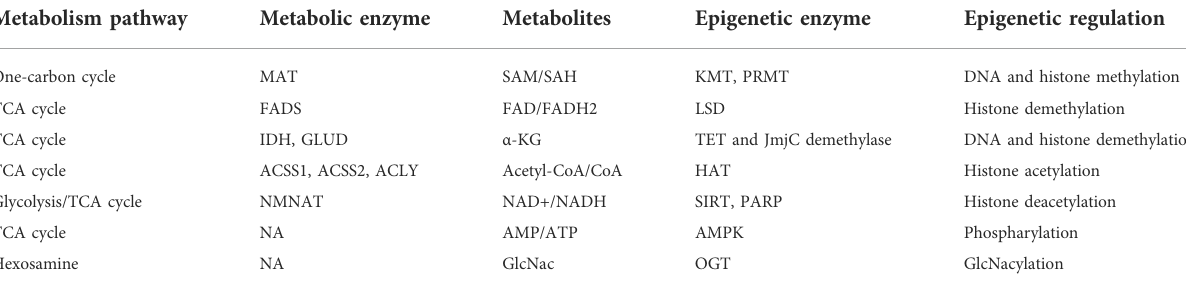
TABLE 1 Fundamental interface of metabolism and